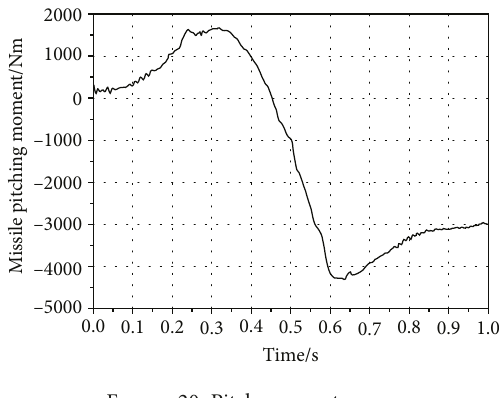
Figure 20: Pitch moment curve.